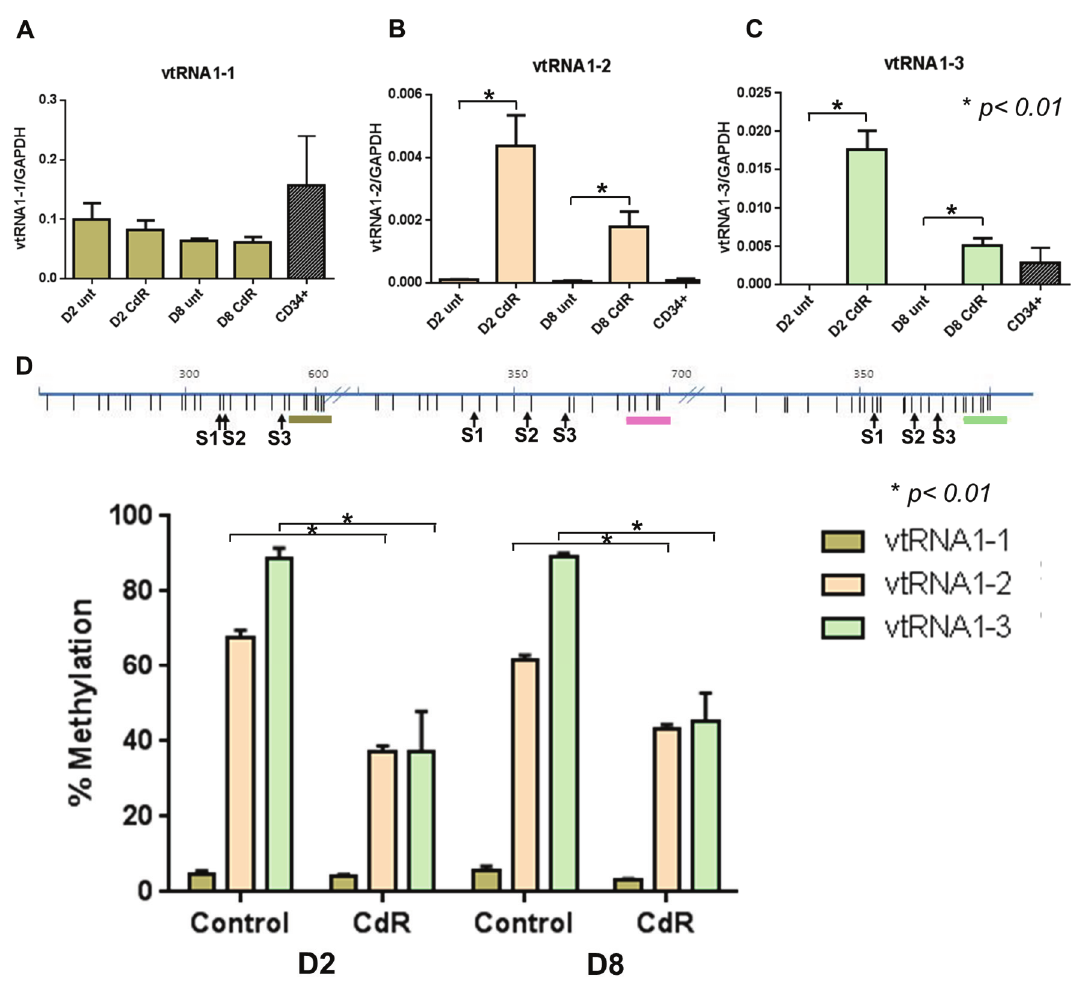
Figure 1. 5-Aza-CdR causes demethylation and reactivation of VTRNA1-2 and VTRNA1-3 . HL60 cells were treated for 24 h with 5-aza-CdR and harvested on day 2 (D2) or day 8 (D8) after treatment. ( A ) Expression of VTRNA1-1 in HL60 and normal CD34+ HSCs; ( B ) Expression of VTRNA1-2 in HL60 and normal CD34+ HSCs; ( C ) Expression of VTRNA1-3 in HL60 and normal CD34+ HSCs; ( D ) Methylation changes determined by Ms-SNuPE in HL60 cells during 5-aza-CdR treatment at VTRNA1-1, 1-2 and 1-3 promoters. The top panel indicates location of CpG sites relative to vtRNA TSSs (brown VTRNA1-1 , pink VTRNA1-2 and mint VTRNA1-3 ) and S1, S2, and S3 indicate the specific CpG sites analyzed by Ms-SNuPE. Mean + SD shown for expression, mean + SEM for methylation data, p -values were calculated by Mann-Whitney U